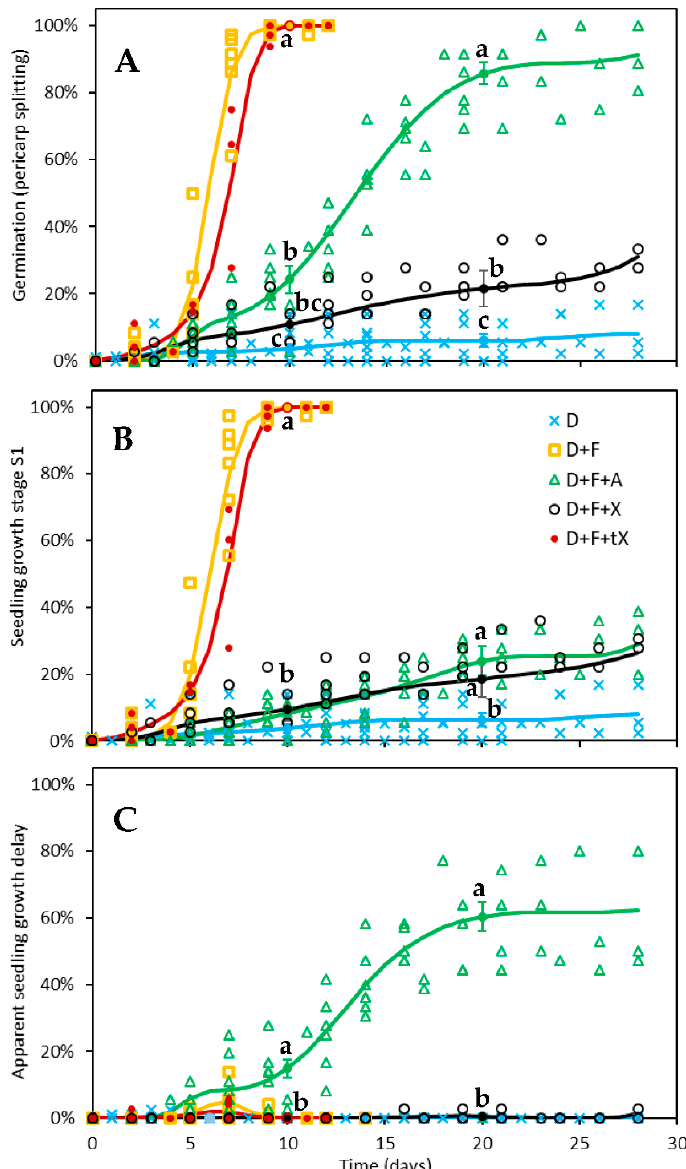
Figure 4. Germination and early seedling growth time-courses of dormant red rice seeds incubated in: 20 mM BTCA pH 4.4 (D, blue crosses) treated with 10 µM fluridone (D + F, yellow squares) plus either 10 µM racemic (±)-ABA (D + F + A, green triangles) or 5 µM cis -xanthoxal (D + F + X, black circles) or 5 µM trans -xanthoxal (D + F + tX, red-filled circles). Every treatment was replicated across three to six independent experimental runs, whose individual datapoints are shown in each plot. A datapoint typically represents the mean of 2–6 (typically 3) replications (12 seeds each). The number of treatment repeats (trp) and of seeds (n) tested for each treatment were as follows: D trp = 6n = 276, D + F trp = 6n = 204, D + F + A trp = 6n = 251, D + F + X trp = 4n = 144, D + F + tX trp = 3n = 120. ( A ) Germination percentage (assessed as pericarp splitting). ( B ) Percentage of seeds attaining first growth stage (S1, i.e., rootlet or coleoptile ≥ 1 mm). ( C ) Difference between observed percentages of growth stage S1 and germination, indicative of a delay of seedling growth once germination was attained. Lines represent the time-course trends based on GzLMM estimations. Statistical differences among treatments were tested at 10 and 20 days ( p ≤ 0.05 within each date; Holm-Sidak test): at each timepoint, treatments labelled with the same letter are not significantly different from each other (only one letter is shown for overlapping responses belonging to the same significance group). Error bars indicate standard